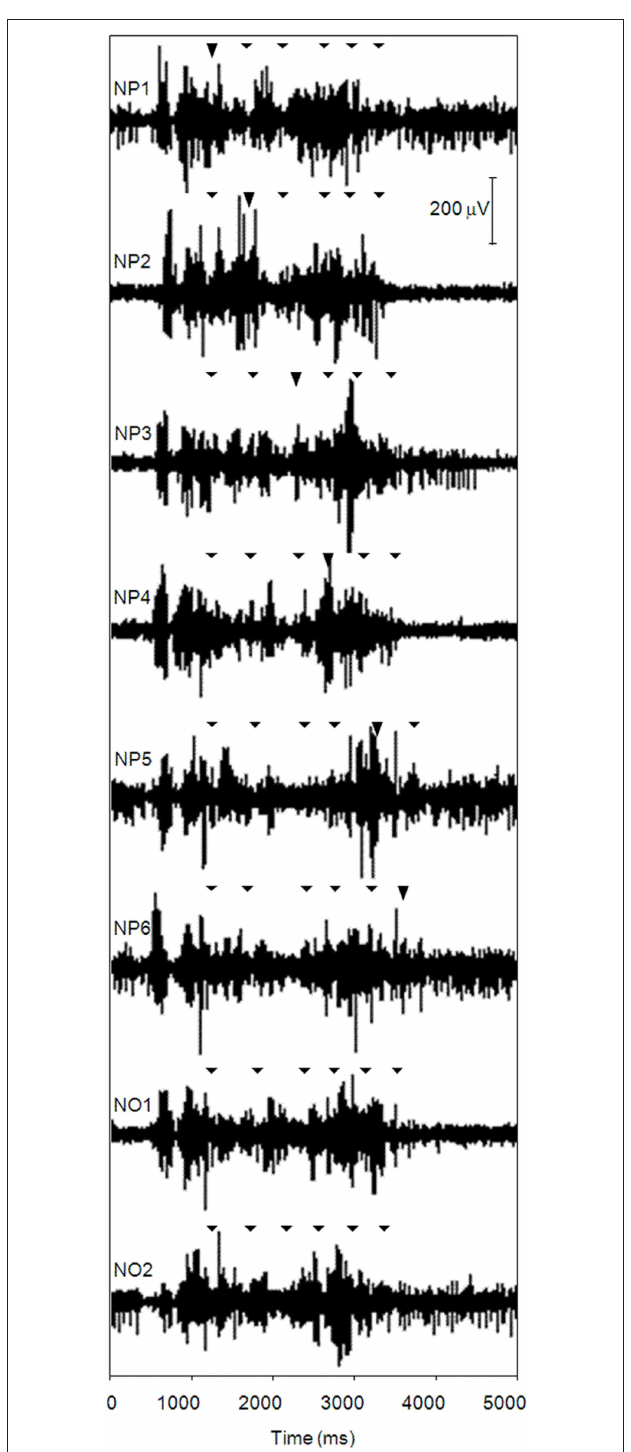
Figure 2 | Lever sequencing: raw electromyographic data of a selected participant (P3), muscle (lateral head of the triceps brachii), and trial (no. 9 out of 16 trials per focus block), for six focus conditions (NP1–NP6) and two no-focus conditions (NO1, NO2). Triangles indicate points in time when configuration 1–6 has successfully been positioned; bold triangles flag the respective in-focus